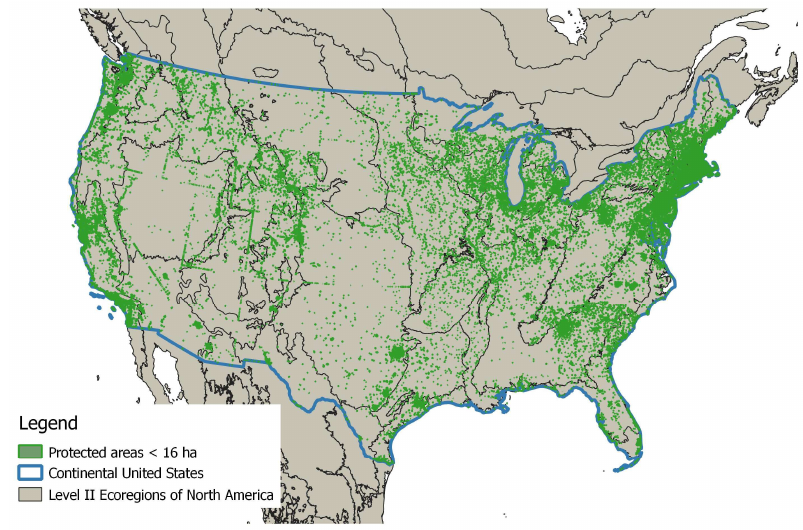
Figure 2. Small protected areas distributed across the continental United States. Shown in green on the map are the protected areas <16 ha, which is the median parcel size for the area shown. Data from PADUS V1.4 Combined Feature Class. QGIS V3.2.